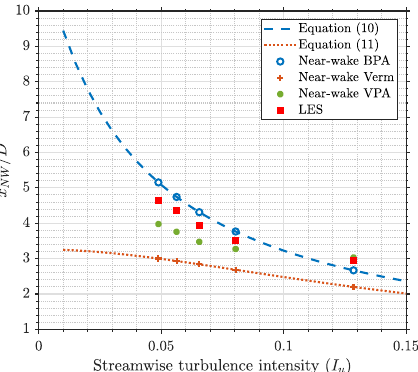
Figure 8. Near-wake length of validation cases as a function of streamwise turbulence intensity: comparison of the presented relationships and the LES data. The symbols represent the validation cases. Equation (10) (BPA model, dashed line) and Equation (11) (Verm model, dotted line) are shown for comparison. Figure adapted from Vahidi and Porté-Agel